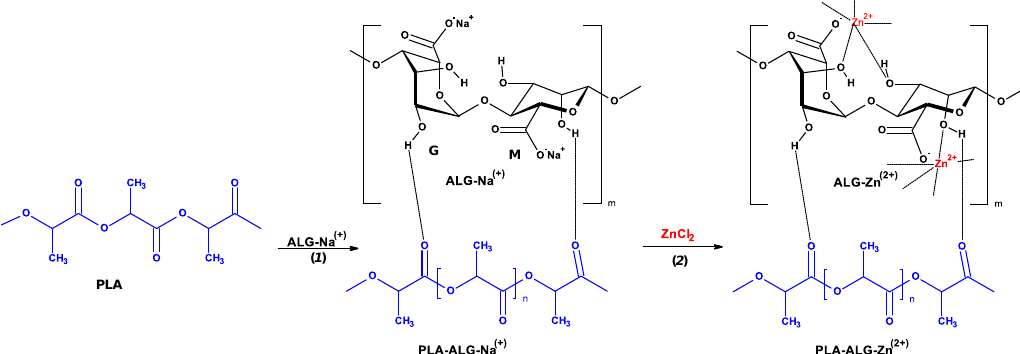
Figure 1. The reactions involved in the preparation of fibrous composite: PLA → PLA-ALG-Na (+) → PLA-ALG-Zn (2+) . The structure of alginate is presented as a linear copolymer – [GM]n- with homopolymeric blocks of (1-4)-linked β -D-mannuronate (M) and its C-5 epimer α -L-guluronate (G) residues.